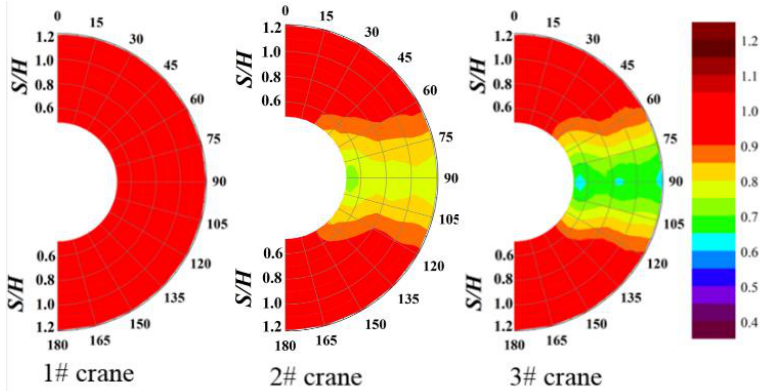
Figure 13. MIF Fy of boom-down cranes.